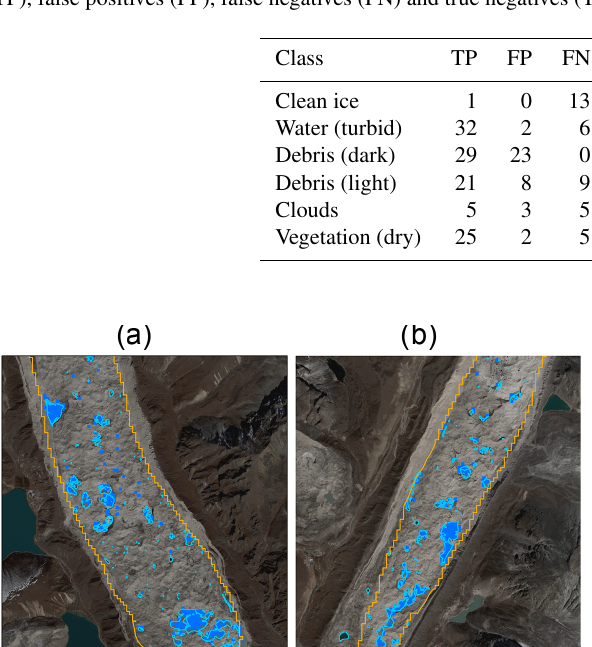
Table 2. Summary of accuracy metrics per class for the Khumbu region, calculated based on the confusion matrix, including true positives (TP), false positives (FP), false negatives (FN) and true negatives (TN).